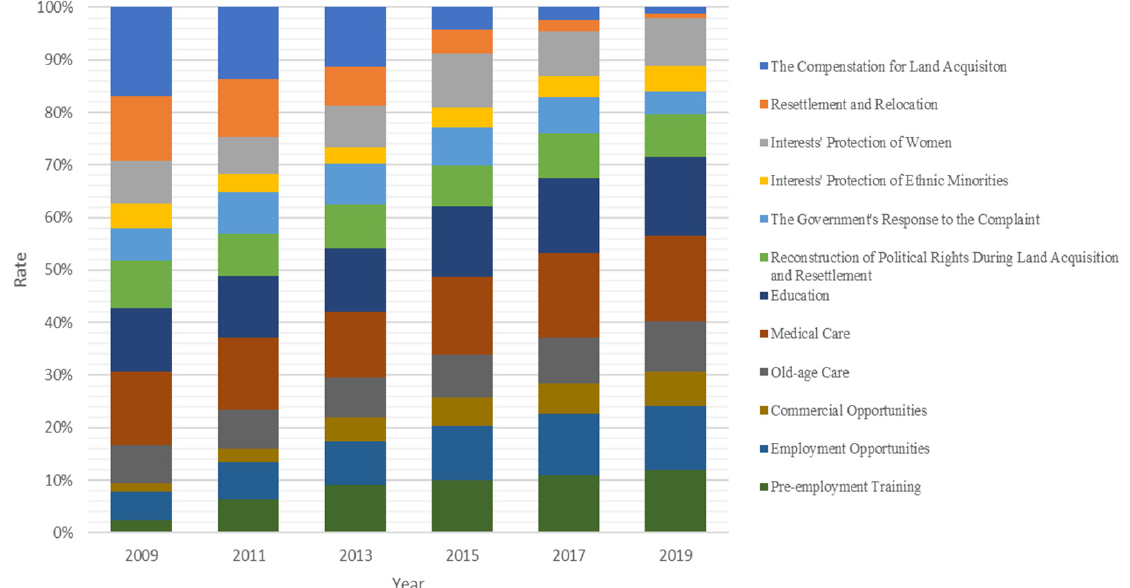
Figure 3. A Sampling of Statistics on Development Opportunities for the APs in the Dongping-Nansi Section of the South-to-North Water Diversion Project (Note: the data are sourced from a field study on the resettlement implementation of the Dongping-Nansi Section of the South-to-North Water Diversion Project, which is conducted by National Research Centre for Resettlement of Hohai University from 2009 to 2019).